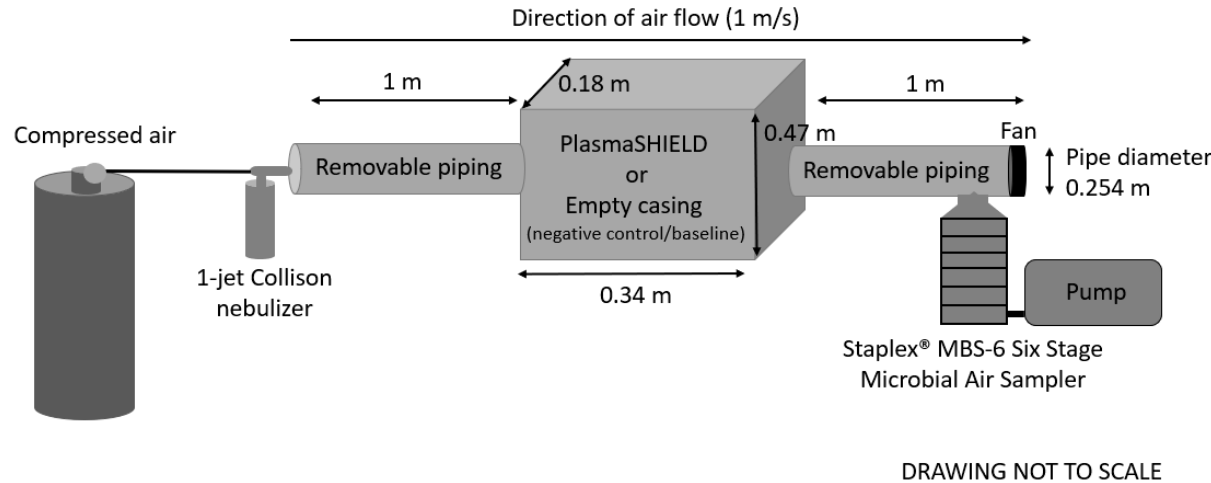
Figure 1. Schematic of experimental setup.